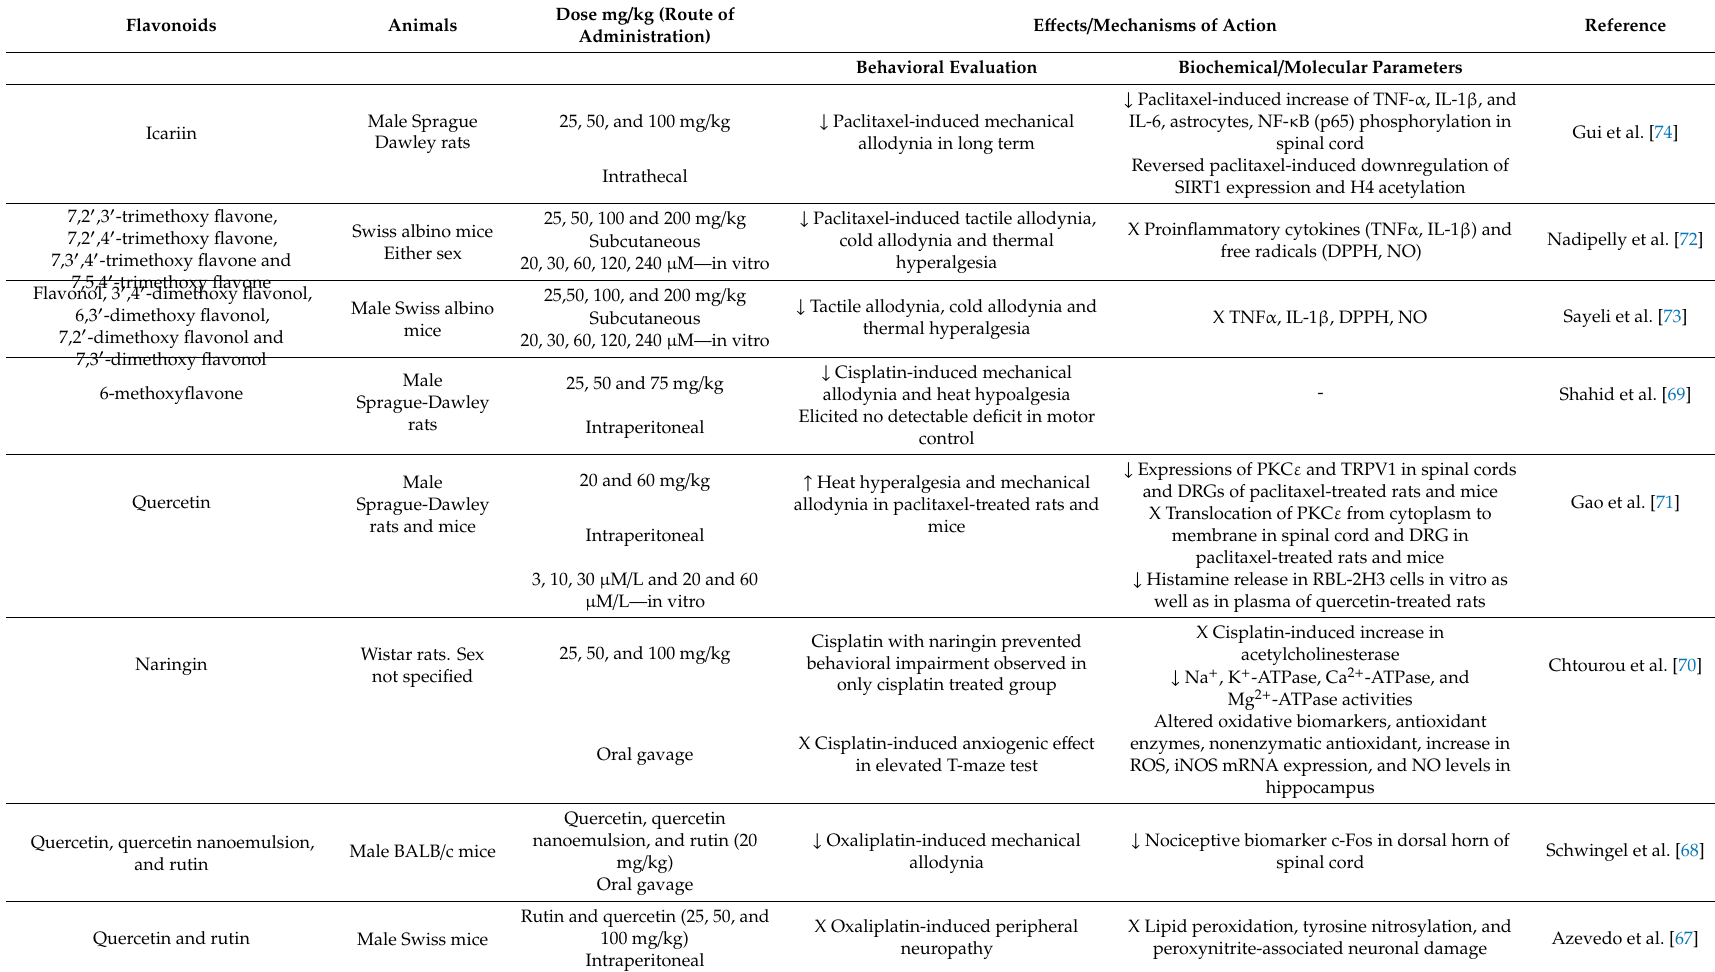
Table 3. E ff ects of flavonoids on chemotherapy-induced peripheral neuropathy